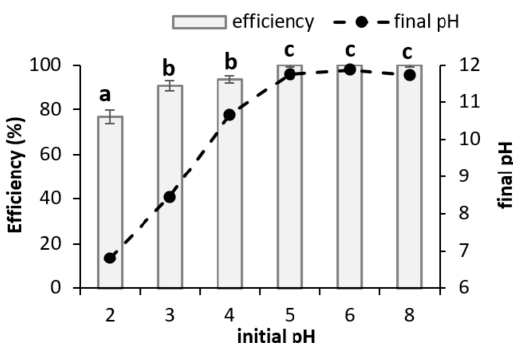
Figure 6. Adsorption efficiency of Cd removal as a function of wastewater (Cd concentration = 100 mg/L, adsorption time = 24 h and ash dosage = 5 g/L). Error bars represent standard deviations ( n = 3). Different letters above bars indicate significantly different efficiencies with different initial pH values (ANOVA followed by Tukey’s honest significant difference test, p < 0.05).